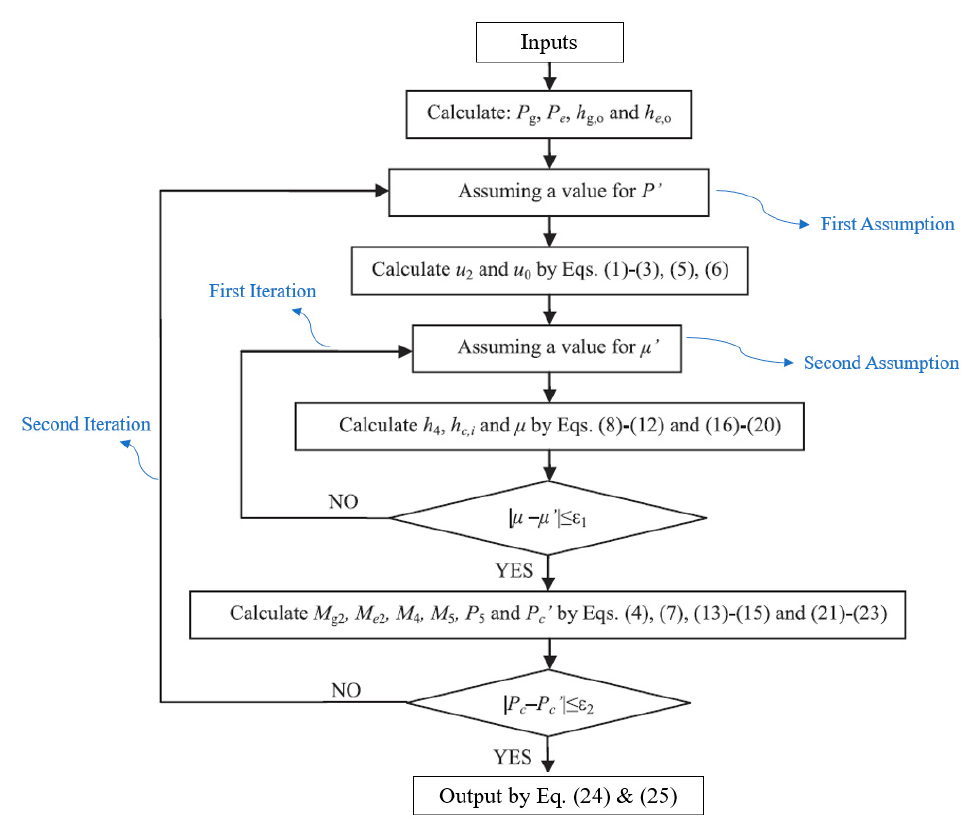
Figure A3. Computation procedure used by Chen [40] for their 0-D model. The developed model is used to run the same EH model from the experiments of Huang et al. [34], and the results are compared with results reported by Chen [40]. Table A3 shows the comparison of the results. As shown, against the experimental result for entrain- EES model gives 0.4122. The percentage difference of 6% indicates a good